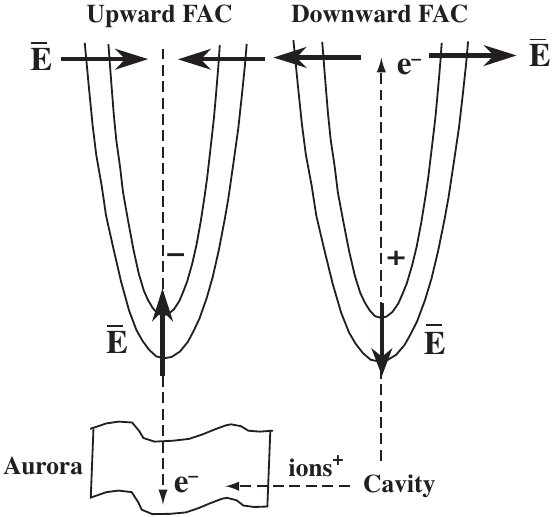
Fig. 21. Schematic figure of the quasi-electrostatic model of auro- ral arcs. Negative and positive potential structures in the magne- tosphere and the acceleration of electrons by these structures are shown. In the ionosphere, the field-aligned currents (FACs) are closed by a perpendicular current carried by ions. Formation of visible aurora and a density cavity are also shown, as discussed in Sect. 4.5 (Figure provided by A.